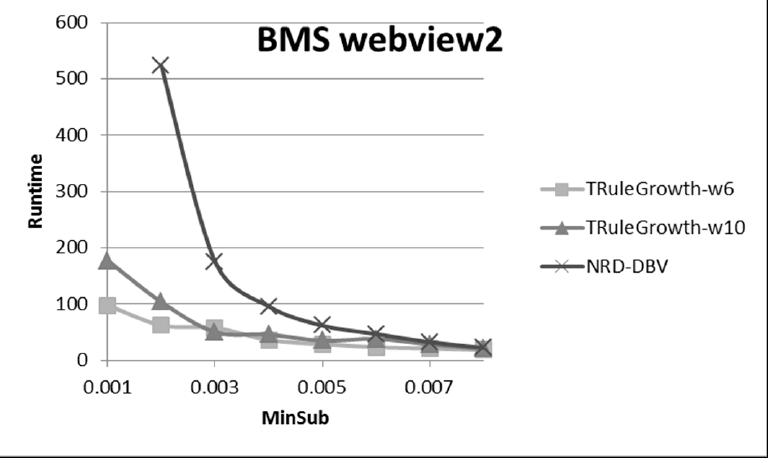
Figure 12. Comparison of memory usage for the TRuleGrowth with the NRD-DBV algorithm for (Korsarak) dataset.